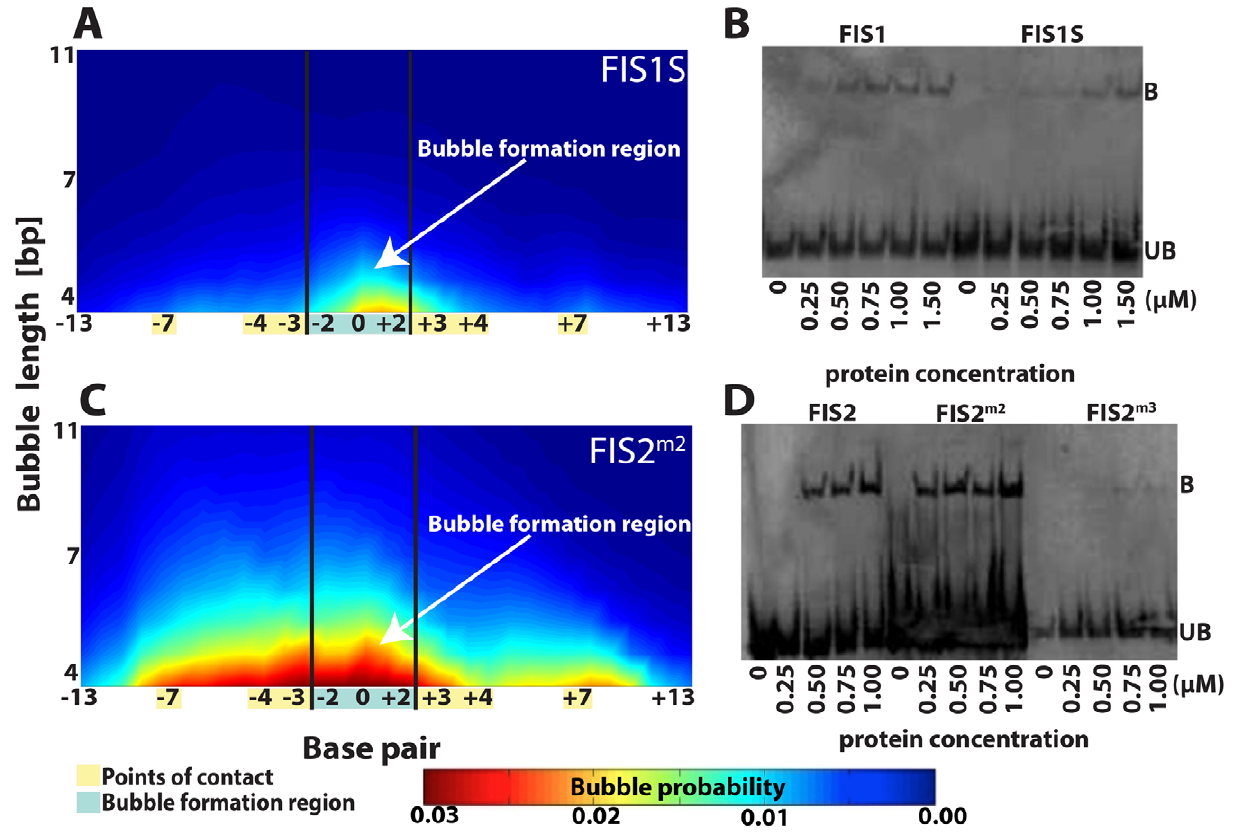
Figure 5. Fis binding site modifications, Langevin dynamics simulations of DNA breathing, and EMSA experiments, the first set. (A) Langevin dynamics simulations demonstrating suppressed local DNA breathing dynamics in the FIS1S sequence (compare to FIS1 in Figure 2). Base pair substitutions were made in the left and right flank regions of FIS1 to create a stiffer sequence while the direct points-of-contact remained unchanged (Table 1). (B) EMSA demonstrating the decrease in affinity of bound FIS1S sequence in complex with purified Fis protein vs. the FIS1 sequence. FIS1 and FIS1S oligonucleotides were constant at 100 nM, and Fis protein ranged from 0 to 1.5 m M. (C) Langevin dynamics simulations demonstrating enhanced FIS2m2 local DNA breathing dynamics (compare to FIS2 in Figure 2). FIS2m2 was designed by introducing two O6- methylguanine in the bubble formation region of FIS2 (Table 1) while the direct points-of-contacts remain unchanged. (D) EMSA demonstrating the increase in complex formation of FIS2m2 vs. FIS2 as well as the decrease in complex formation in FIS2 m3 (third set of lanes). Oligonucleotide sequences were constant at 100 nM, and Fis protein ranged from 0 to 1.5 m M (for each of the lanes). Sonicated salmon sperm DNA at 0.5–1 m g/ m l was added to the binding reactions to eliminate non-specific binding. In Langevin dynamics (panels A and C) the probability of bubble openings is represented by the same color map; red denotes high probability and blue denotes low probability of opening. The length of the transient bubbles, given in base pairs [bp], is shown along the vertical axis. The horizontal axis depicts base pair position; the bubble formation region is highlighted in blue while the points-of-contact are highlighted in yellow. The names of each of the sequences are shown in the panels while the complete nucleotide sequences could be found in Table 1.